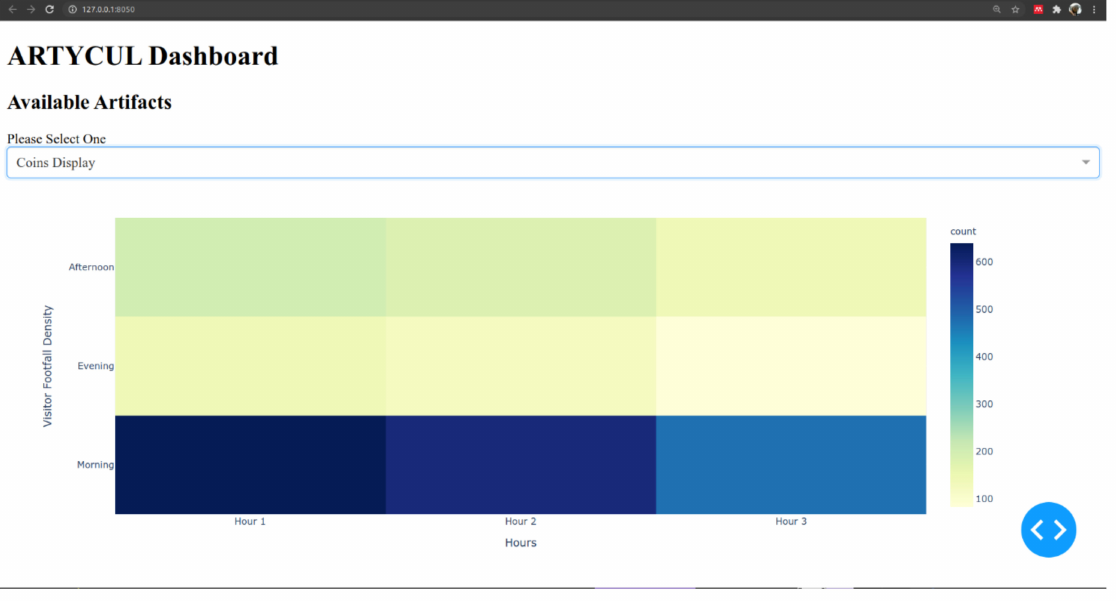
Figure 13. A prototype of the popularity dashboard module of